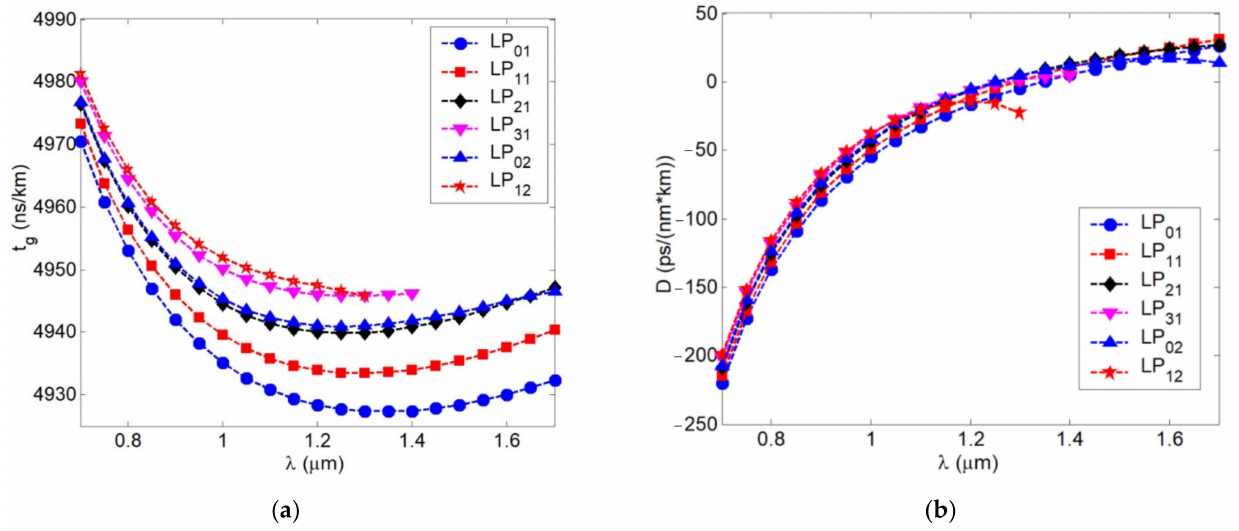
Figure 7. Spectral characteristics of guided mode dispersion parameters: ( a ) mode delay; ( b ) chro- matic dispersion